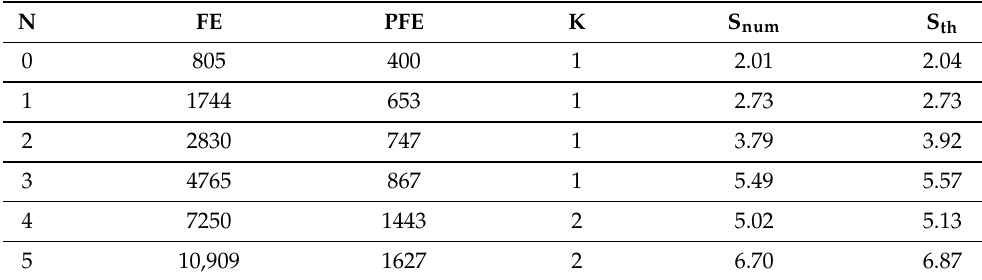
Table 12. Smooth periodic wave test case runtime and speedup using FE and PFE schemes for differ- ent N and constant n x = 2000, λ = 10 − 4 shows significant speedup close to the theoretical prediction. N